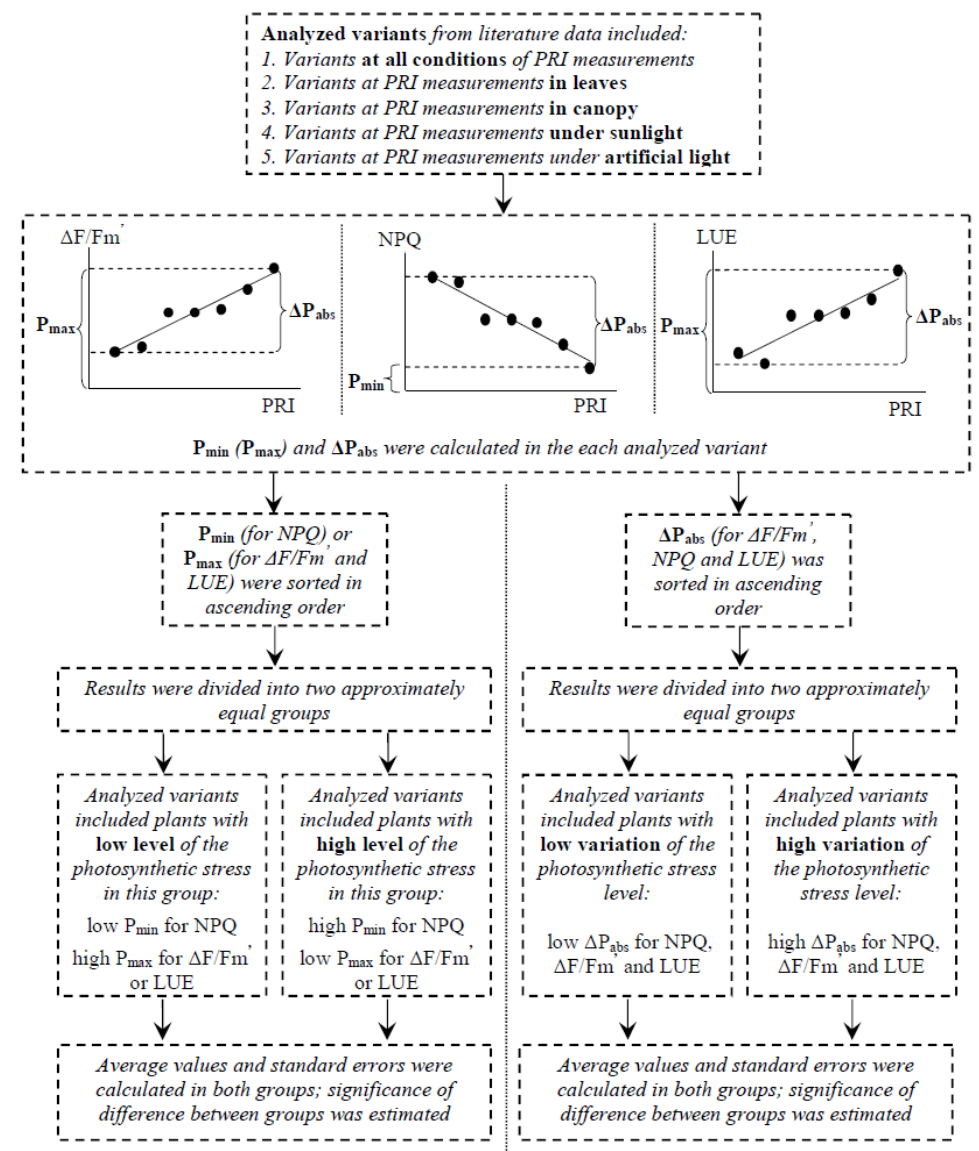
Figure 1. The common design of the analysis of influence of photosynthetic parameter distribution on investigated plants for their connection with PRI. P min is the minimal value of NPQ among plants (or groups of plants) in each analyzed variant; P max is the maximal value of ΔF/F m ’ or LUE among plants (or groups of plants) in each analyzed variant; ΔP abs is the difference between P max and P min for ΔF/F m ’, NPQ, and LUE in each analyzed variant.